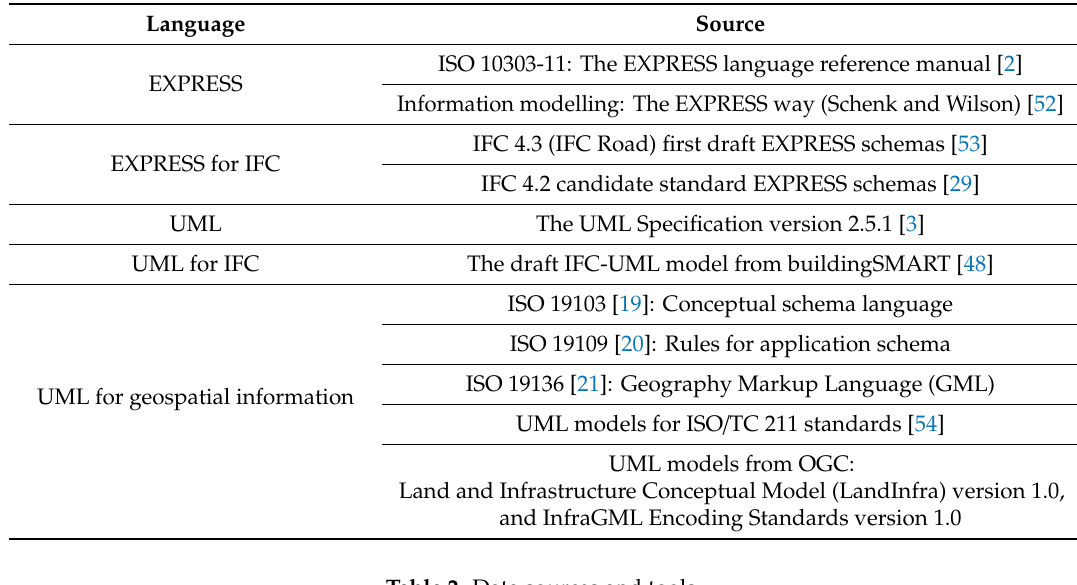
Table 1. Sources for comparisons of IFC EXPRESS and ISO / TC 211 UML.